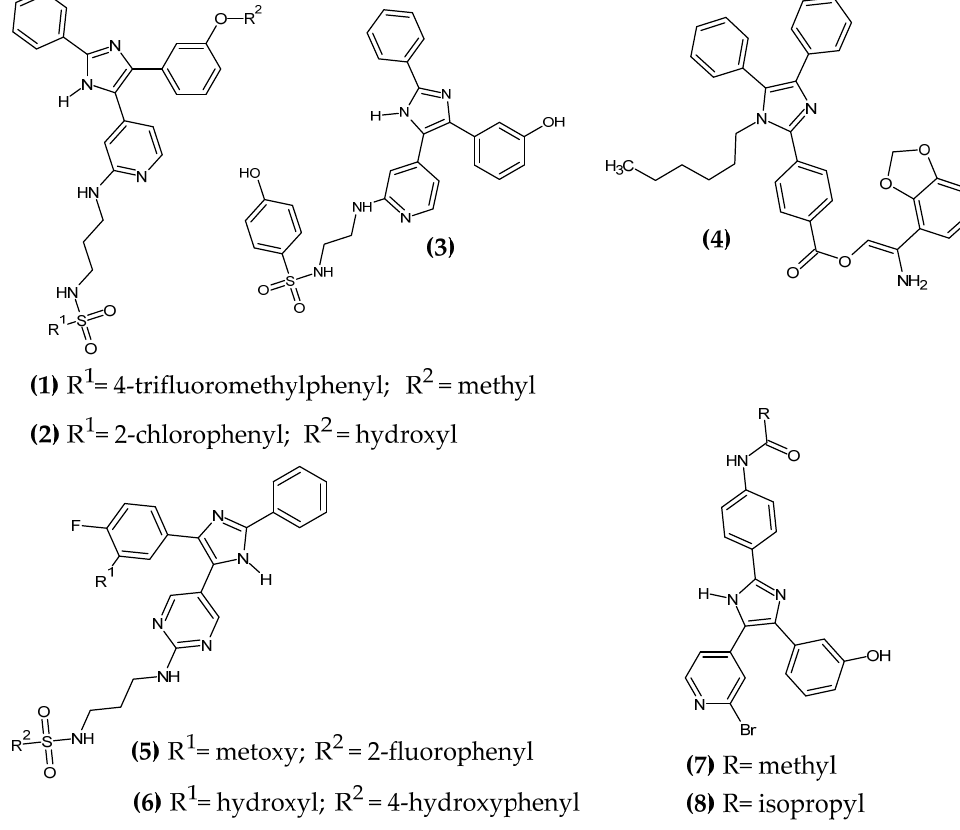
Figure 2. Imidazole derivatives with anti-melanoma